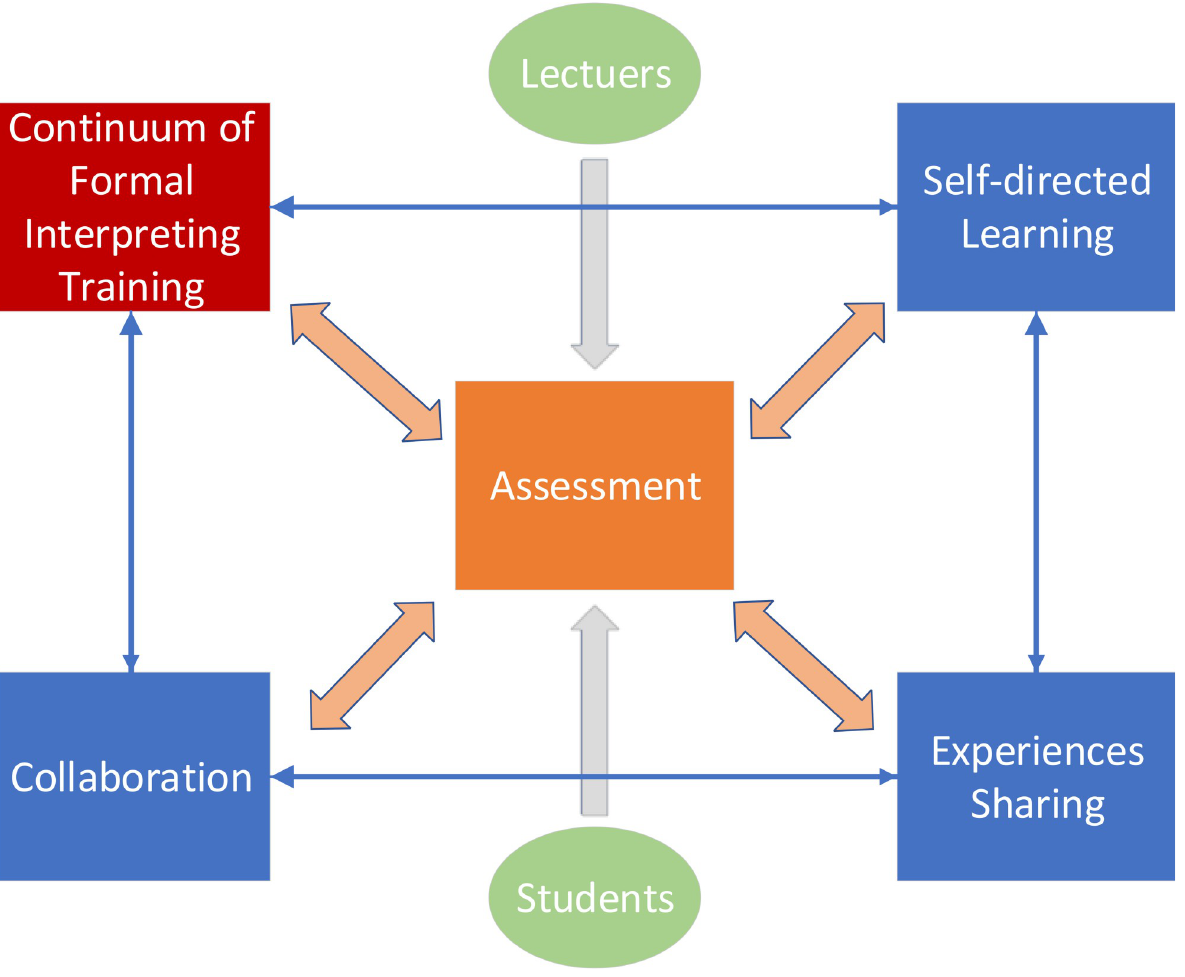
Fig 1. Conceptual model of informal learning